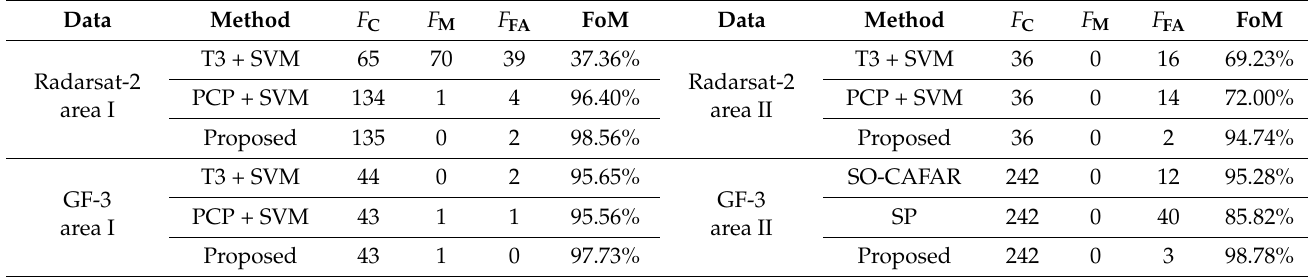
Table 3. Quantitative results’ comparison with the GF-3 area II training set.